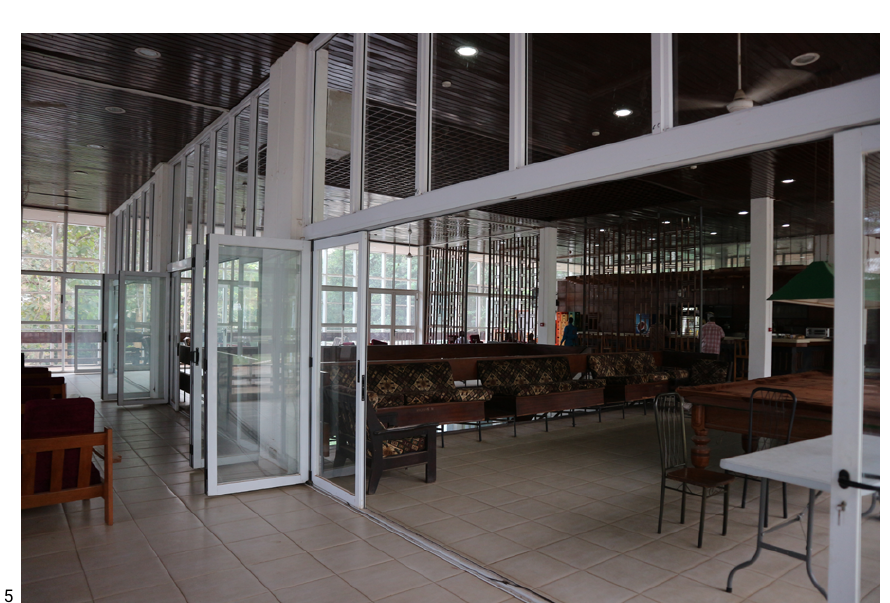
Miro Marasović and Nikša Ciko, Senior Staff Club House, 1965 (Source: Z. Ciko private